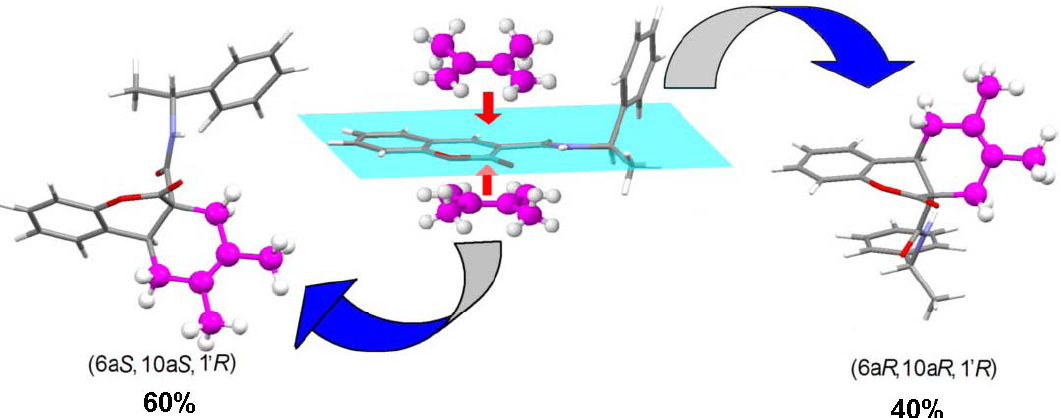
Figure 1. Calculated molecular structures of the (6a S ,10a S ,1’ R ) and (6a R ,10a R ,1’ R ) diastereomers of the cycloadduct 8a . In the former (left) the methyl protons of the chiral amine residue lie in the shielding cone of the coumarin benzenoid